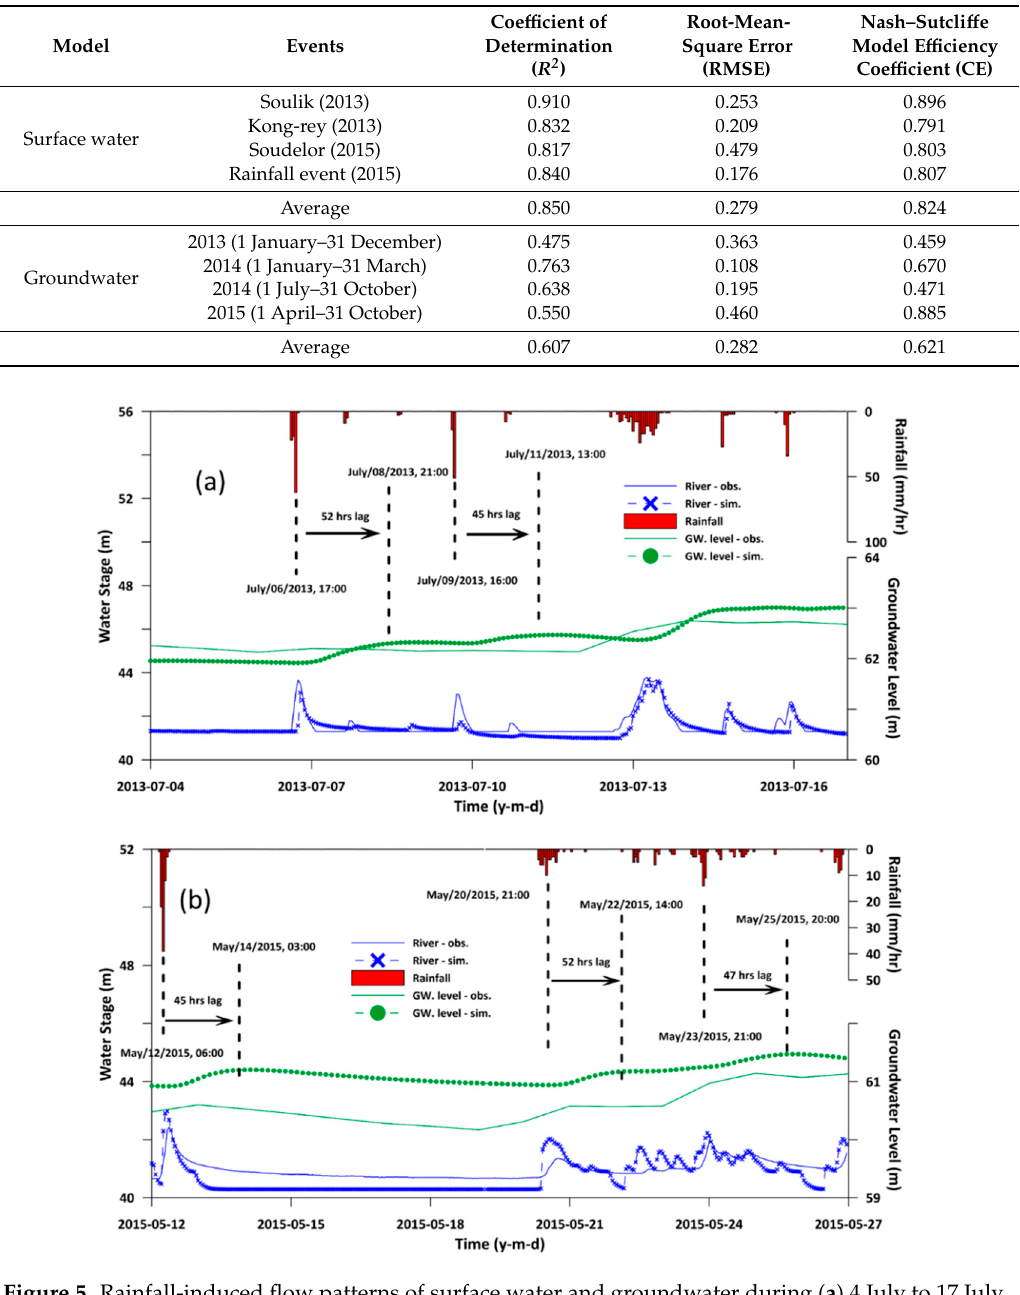
Table 2. Error indicators for evaluating the performance of the surface water / groundwater model.